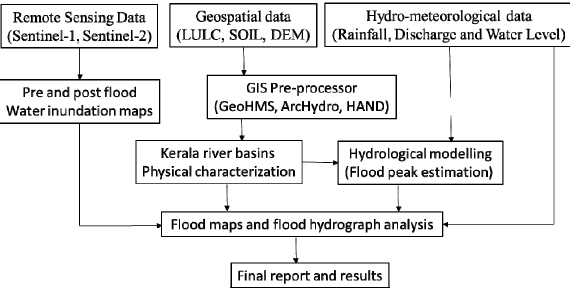
Figure 3. Overall methodology used for integrated hydrological study of Kerala 2018